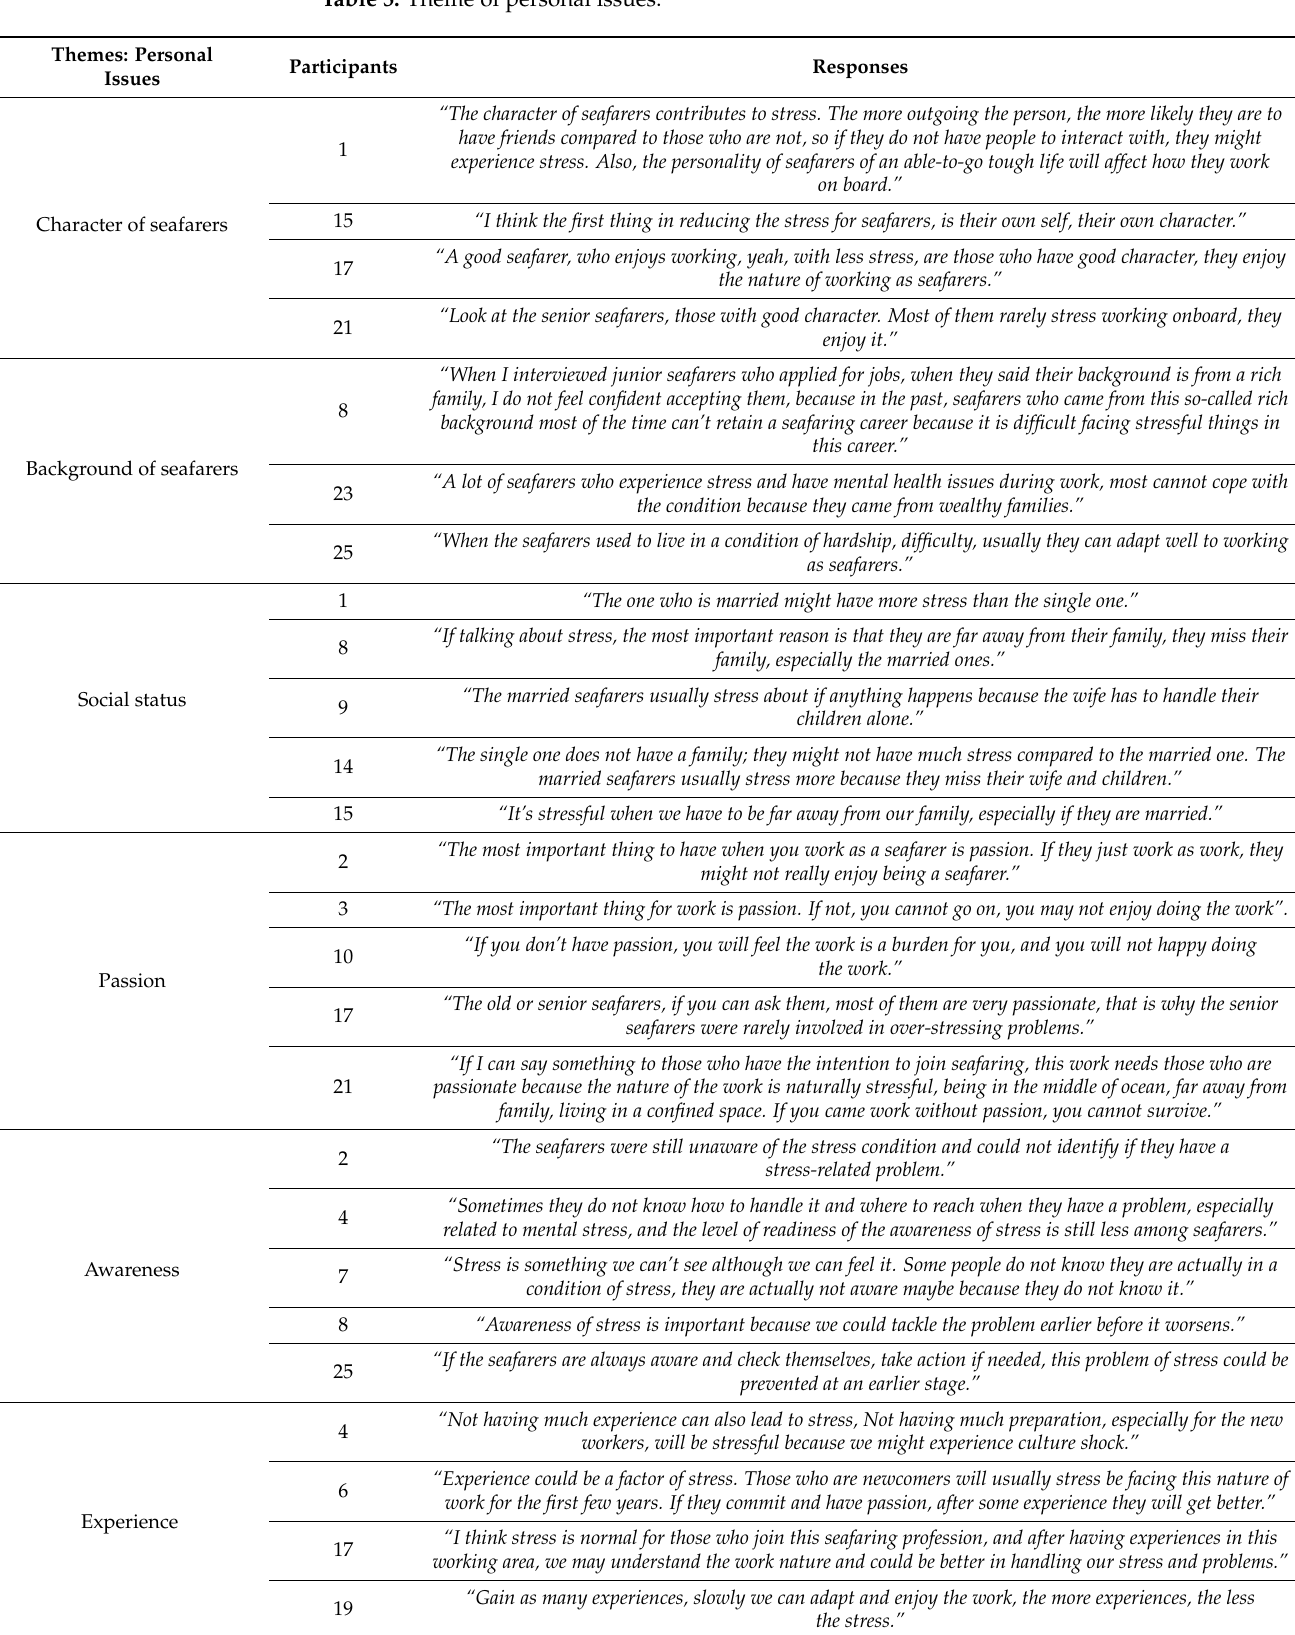
Table 5. Theme of personal